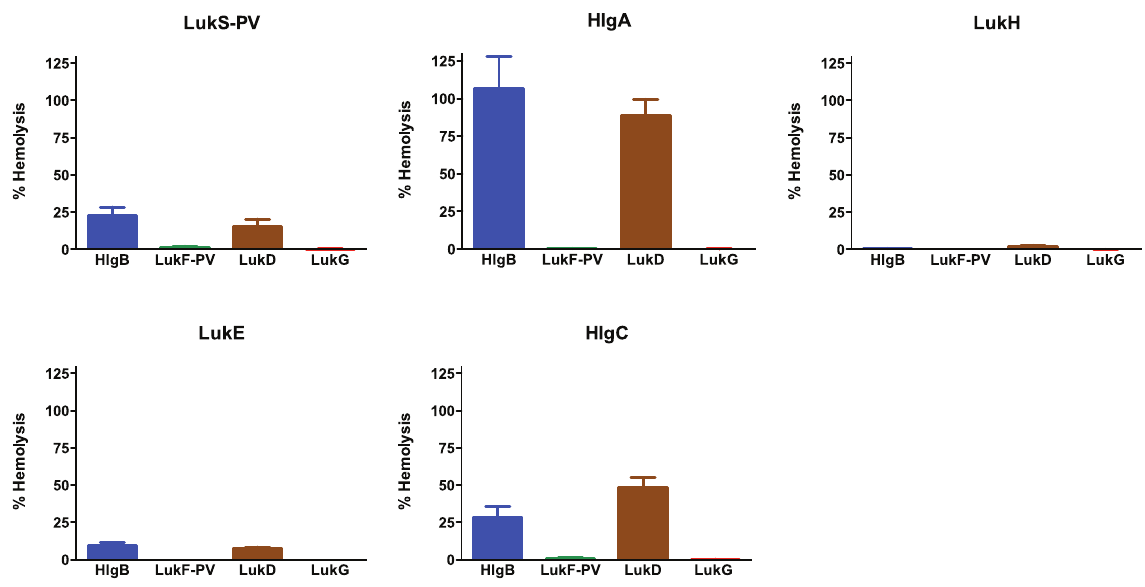
Figure 5. Hemolytic activity by combinations of S and F components from LukGH, PVL, LukDE, and c -hemolysin. Five percent rabbit RBCs were incubated with BCL pairs at 500 nM for 1 h at 37 u C in a 96-well round-bottom plate. After pelleting intact cells, supernatants were transferred to a new plate and the absorbance at 450 nm was measured. Hemolysis was calculated according to the formula described in the methods section by using 20 m g/mL S. aureus a -toxin to determine complete RBC lysis. The results shown are the mean of three independent experiments 6 SEM. Each panel shows a particular S component (header) as mixed with various F components (LukG: red, LukF-PV: green, LukD: brown, HlgB: blue). doi:10.1371/journal.pone.0089308.g005 cell types, including RBCs [1,2]. Studies of LukGH cell specificity PMNs and monocytes but not lymphocytes or RBCs [1,2]. On the suggest activity against PMNs, monocytes and dendritic cells [11,12]. We have ascertained that LukGH does not have activity